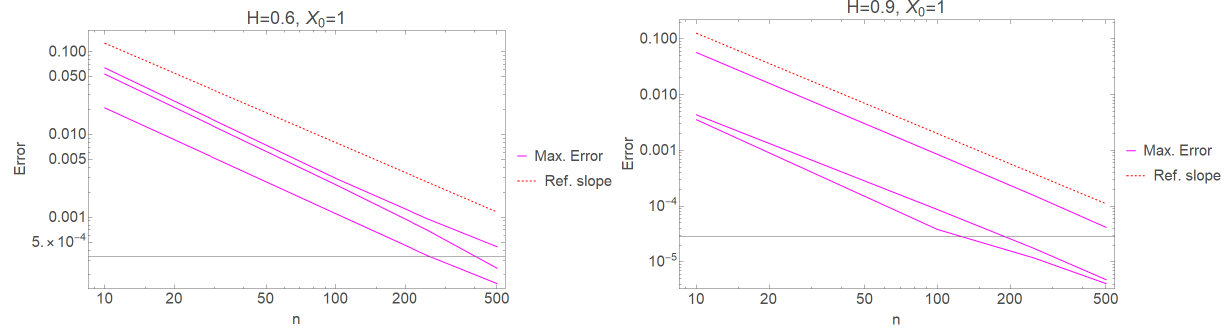
Figure 2. Maximum error of several approximation trajectories of Pearson process for conditions (19) in comparison to reference